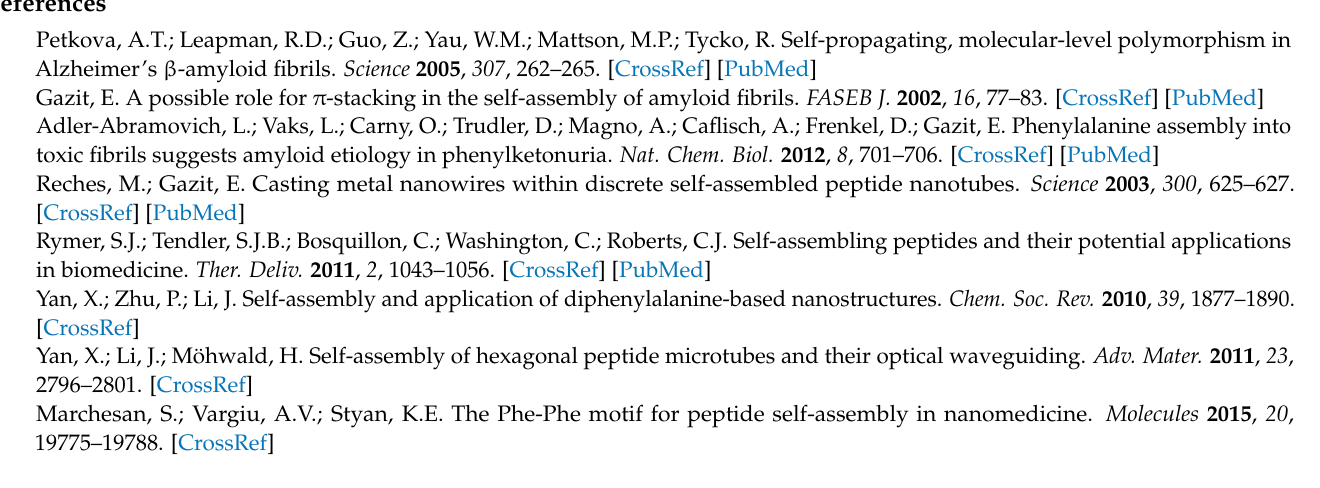
Figure S7: Comparison with previous assignment for conformer B of the FF monomer, Figure S8.1–2: Theoretical IR spectra of the structural families of the FF dimer, Figure S9: REMPI spectrum of the FFF dimer, Figure S10: Possible structure of the FFF dimer, Table S1: Experimentally observed and calculated frequencies in the amide I and II region for the PhgPhg monomer, Table S2: Experimentally observed and calculated frequencies in the amide I and II region for the PhgPhg dimer, Table S3: Experimentally observed and calculated frequencies in the amide I and II region for the FF